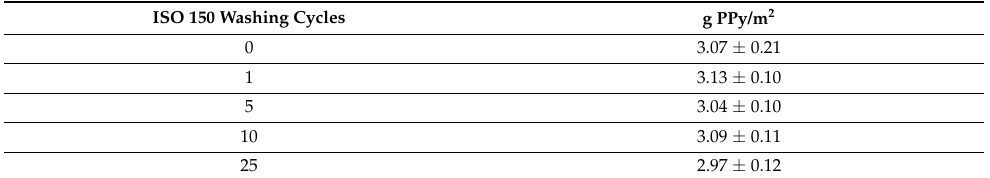
Table 2. PPy amount on cotton fabric measured by colorimetric analysis after different washing cycles (ISO